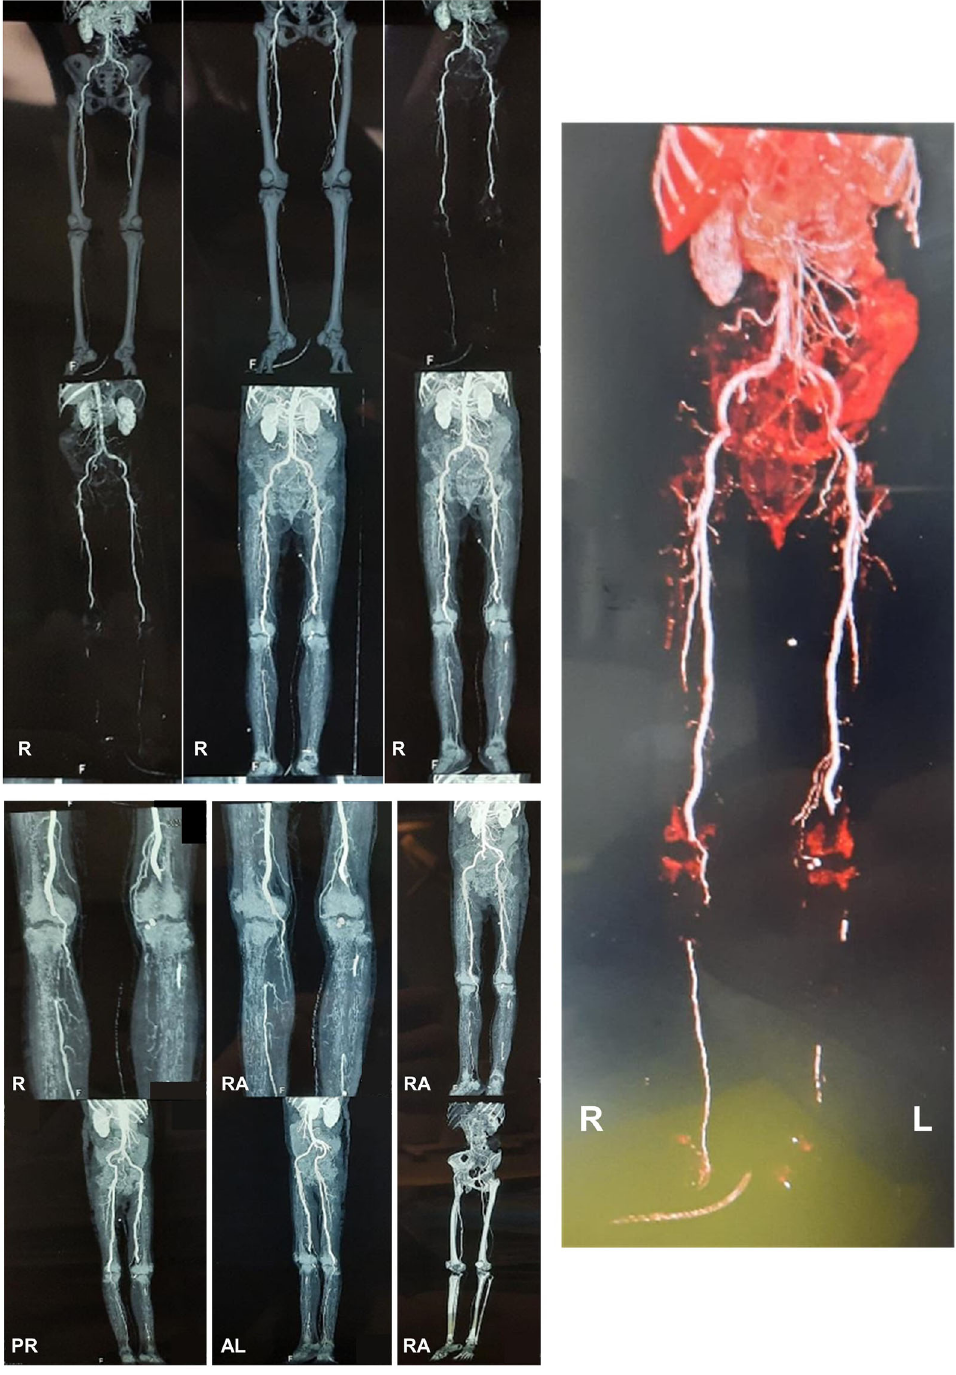
Figure2.Thecomputedtomographyangiography(CTA)ofthelowerextremity. TheCTArevealedanabdominal aortosclerosis with abnormalities on both limbs. Right limb: total occlusion due to 6 cm thrombus on right popliteal artery (from 1 cm above right femorotibial joint toward inferior), right anterior tibial artery received contrast flow from collateral arteries and no contrast flow was seen in right posterior tibial, peroneal and dorsalis pedis arteries. Left limb: total occlusion due to 12.7 cm thrombus on left popliteal artery (from 6 cm above left femorotibial joint towardinferior).Nocontrastflowwasseeninleftanteriortibial,posteriortibial,peronealanddorsalispedisarteries. (This figure has been edited in Microsoft PowerPoint 2016 to obscure patient ’ s